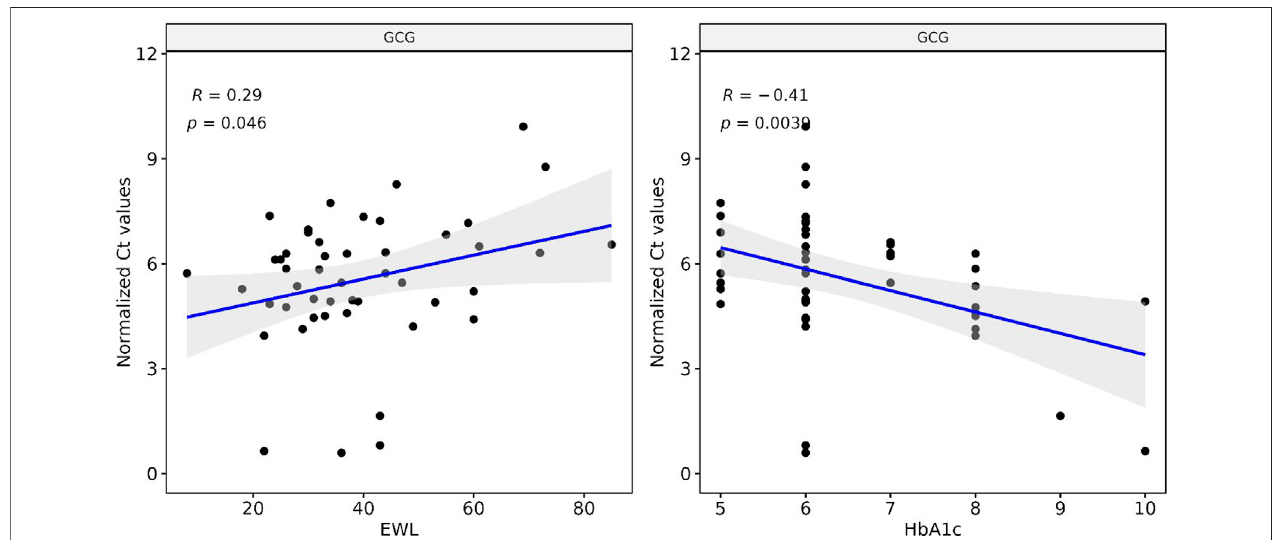
FIGURE 3 | LevelsofGCG cfmRNAcorrelateswithclinicalbiomarkersHbA1c and %EWL(Percent excessweightloss) CtmeasurementsofGCG cfmRNAacrossall patientsandvisitsarecorrelatedwith%EWLandHbA1clevels.Linearregressioncapturesasigni fi cantpositivecorrelationwith%EWLandaninversecorrelationwithHbA1c.